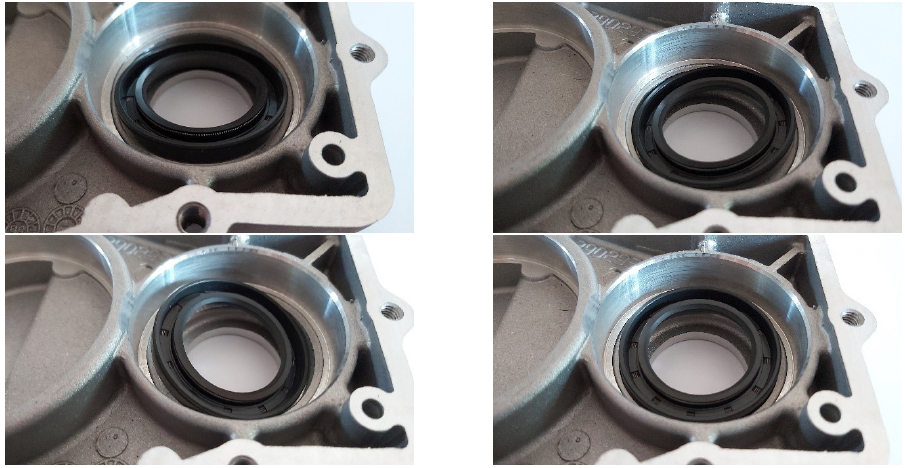
Figure 16. Possible positioning of the oil seal above its house before the use of the hydraulic